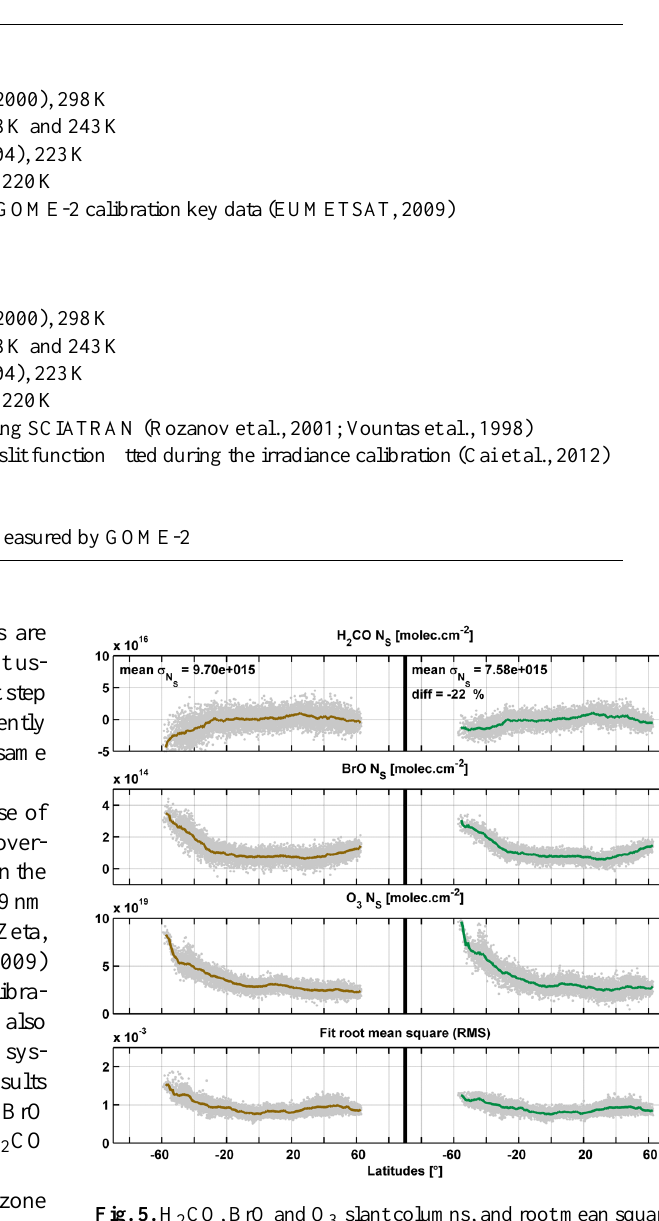
Fig. 5 show the H 2 CO differential slant columns before and after the corrections (left and right column); the mean stan- dard deviation σ N are inset each plot. The second and s